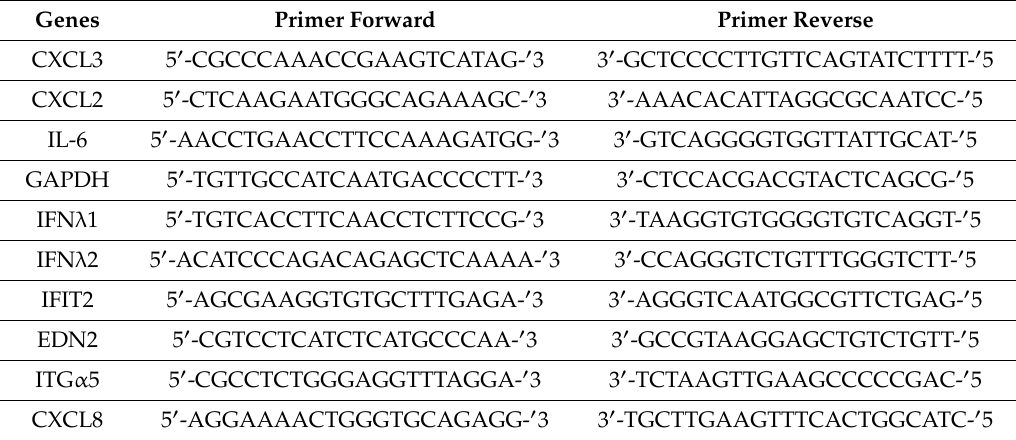
Table 1. Primers used for